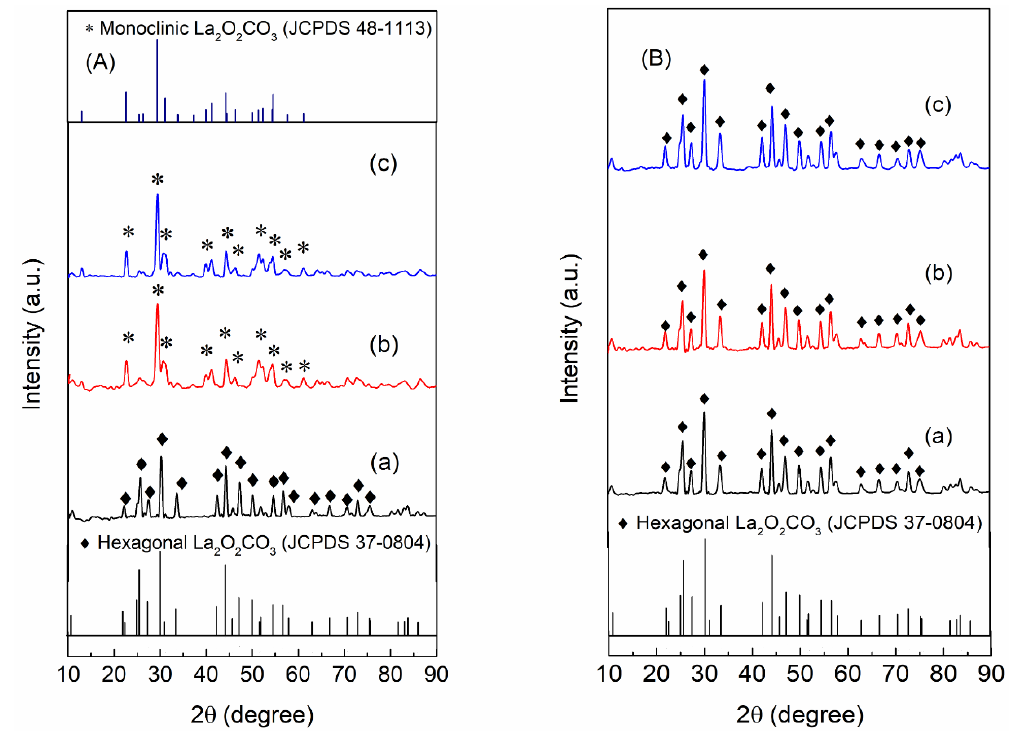
Figure 1. XRD patterns of A ( a – c ) PL-6h, PL-12h, and PL-24h and B ( a – c ) HL-6h, HL-12h, and HL-24h.